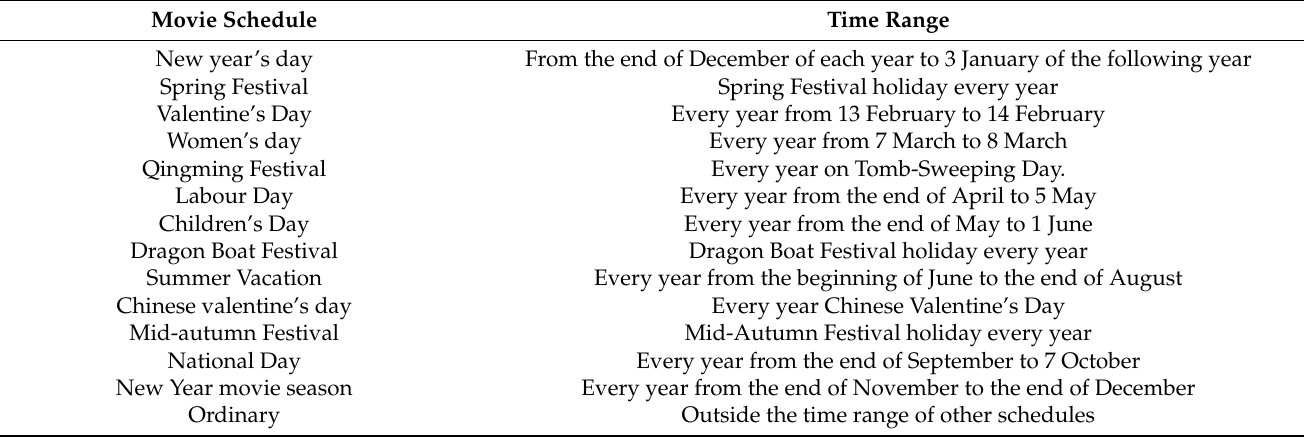
Table 5. Movie schedule time range.